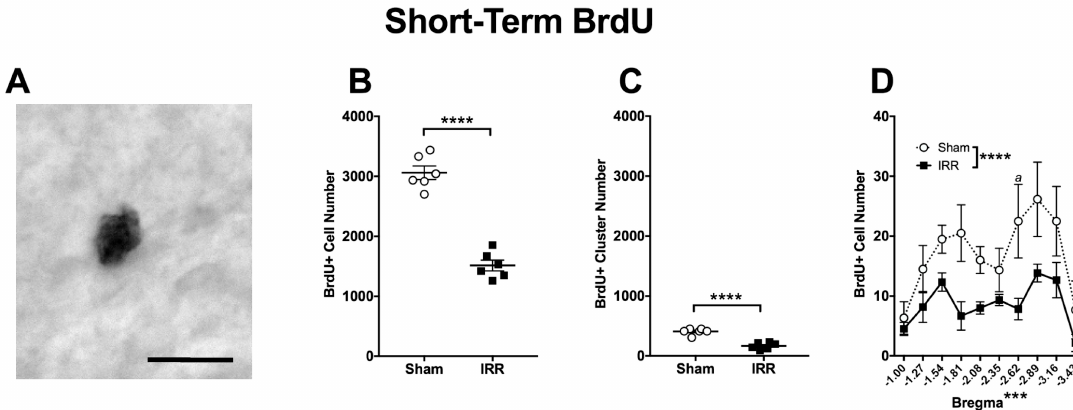
Figure 4. 24-h post-irradiation, whole-body exposure to 12 C irradiation reduced the number of DG GCL BrdU+ cells and clusters relative to Sham treatment. ( A ) Representative photomicrograph of BrdU staining in a Short-Term Sham mouse (mouse #14086; 400×, scale bar = 25 µm). ( B ) An unpaired two-tailed t -test revealed fewer BrdU+ cells in the DG GCL 24-h after 12 C irradiation versus Sham treatment (**** p < 0.0001; N = 6 Sham, N = 6 IRR). ( C ) An unpaired t -test revealed fewer BrdU+ clusters in the DG GCL 24-h after 12 C irradiation versus Sham treatment (**** p < 0.0001). ( D ) Bregma analysis of BrdU+ cells in the DG GCL through two-way ANOVA (Bregma × Treatment) revealed main effects of Treatment ( F 1,10 = 115.4; **** p < 0.0001) and Bregma ( F 9,90 = 3.668; *** p < 0.001), but no significant interaction ( F 9,90 = 0.6751; p > 0.05). Post-hoc (Sidak’s multiple comparison) test revealed fewer BrdU+ cells at bregma − 2.62 in IRR mice relative to Sham mice ( a p < 0.05). Error bars ± SEM.